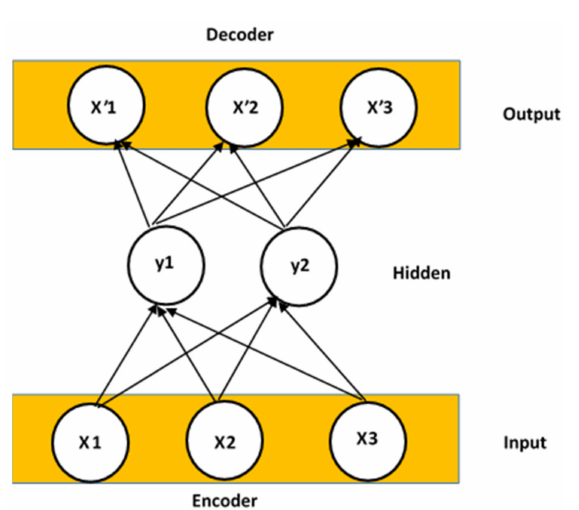
Figure 4. The general architecture of an autoencoder (AE) neural